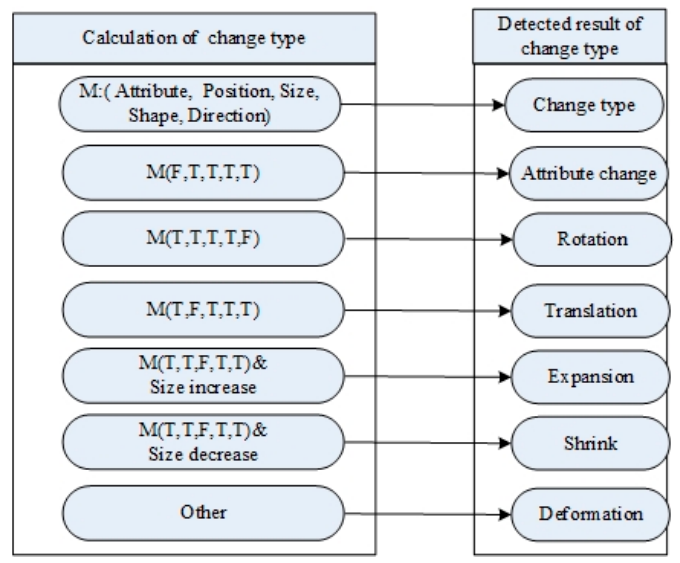
Figure 3. Illustration of type-of-change detection.